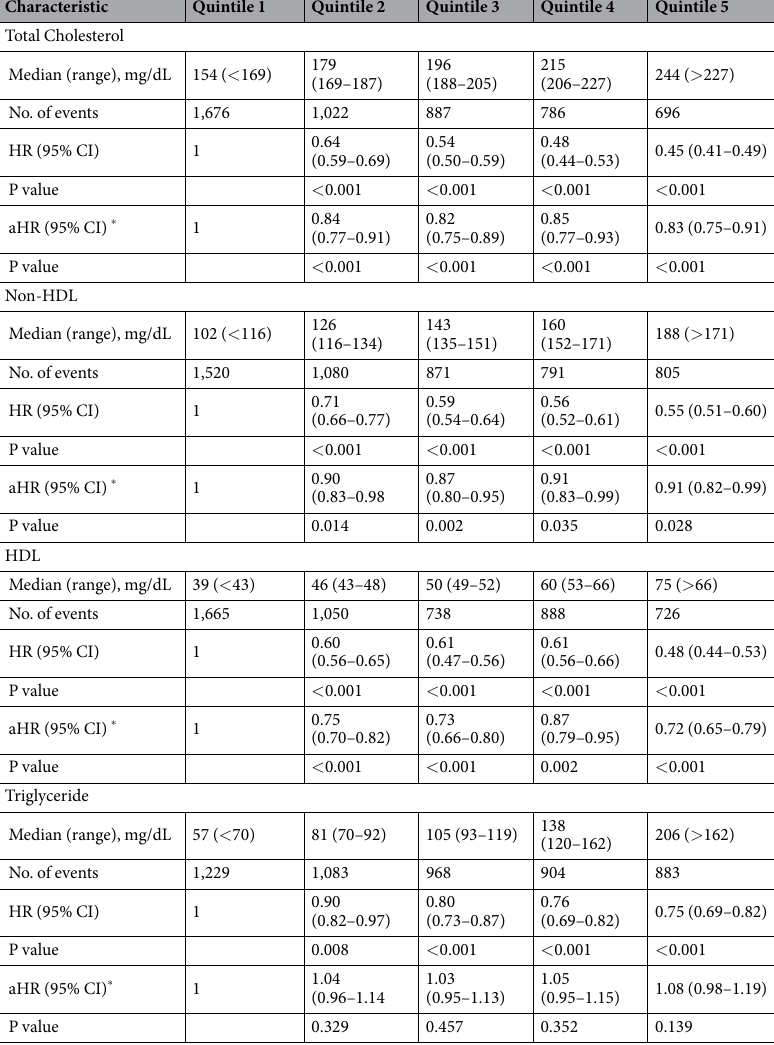
Table 2. Mortality Risks among Older Participants According to Baseline Lipid Levels. * Adjusted for age, sex, body mass index, smoking, alcohol use, systolic blood pressure, diastolic blood pressure, hypertension, diabetes mellitus, coronary artery disease, cerebrovascular disease, white blood cell count, hemoglobin, albumin, geriatric nutritional risk index, uric acid, fasting glucose, estimated glomerular filtration rate, and urine protein level. Abbreviations: HR, Hazard ratio; aHR, adjusted hazard ratio; CI, confidence interval; HDL, high-density